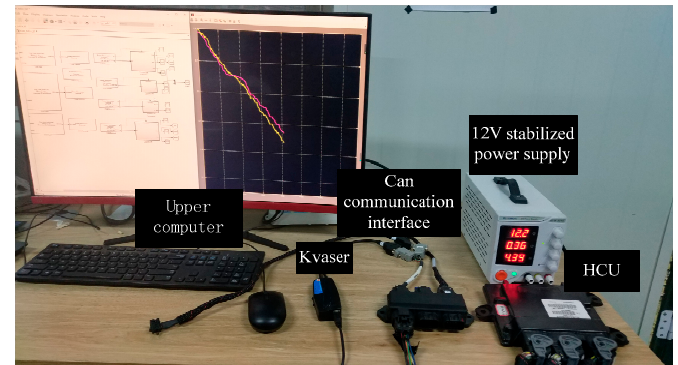
Figure 19. The Hardware-in-Loop (HIL) platform.